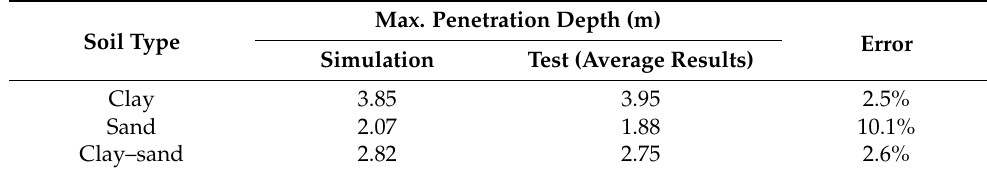
Table 3. Comparison of anchor pile penetration